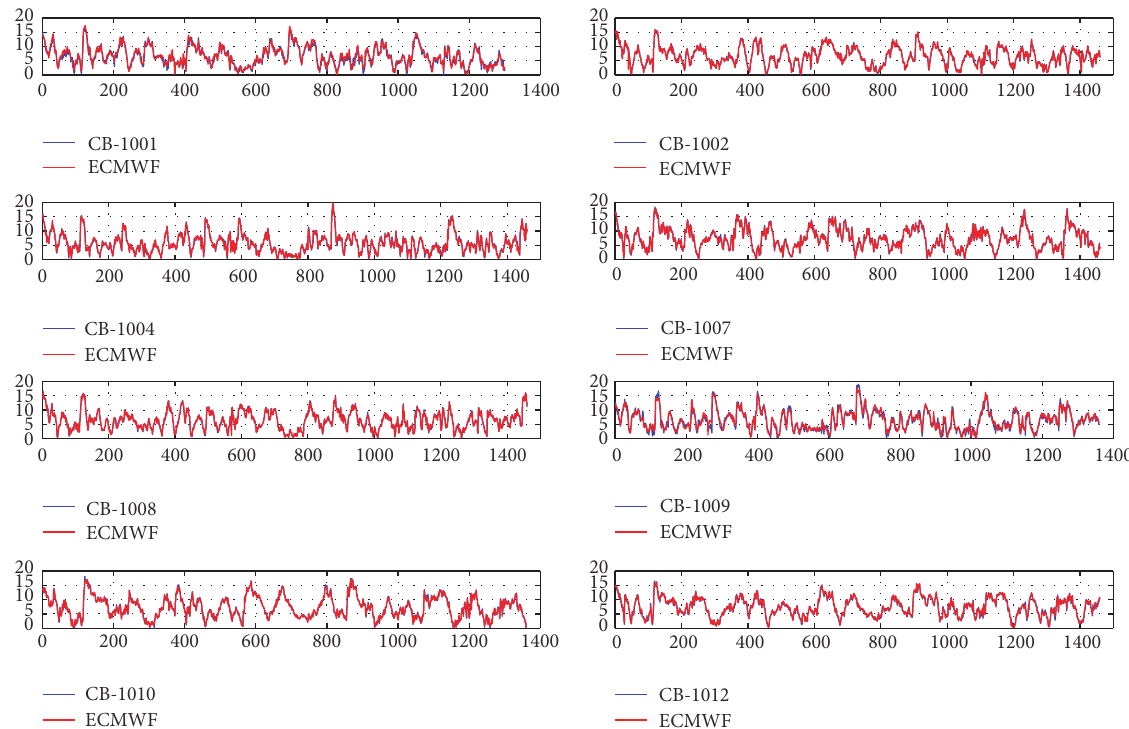
Figure 2: Time series of observed (buoy) and satellite (ECMWF) data for the wind speed for the period of 2015 around the ECS for stations CB-1001, 1002, 1004, 1007, 1008, 1009, 1010, and